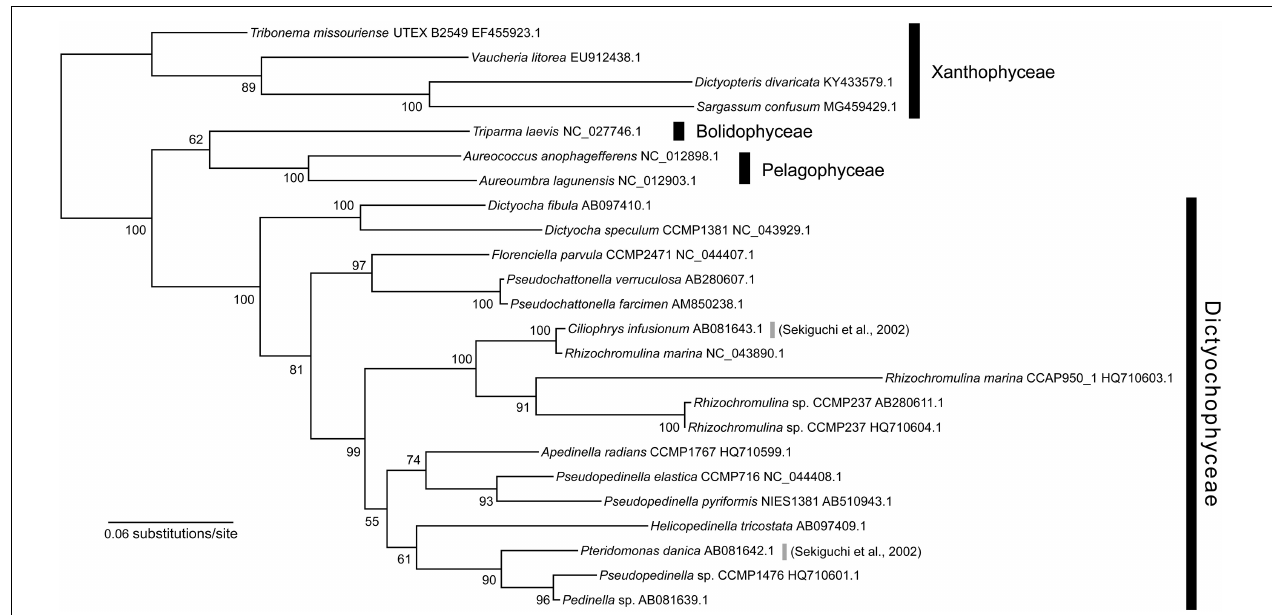
FIGURE 4 | Maximum likelihood tree of rbcL gene sequences of Dictyochophyceae. The tree was inferred with IQ-TREE 1.6.12 under the GTR + (cid:48) + I + F model. Bootstrap values ≥ 50 are shown on